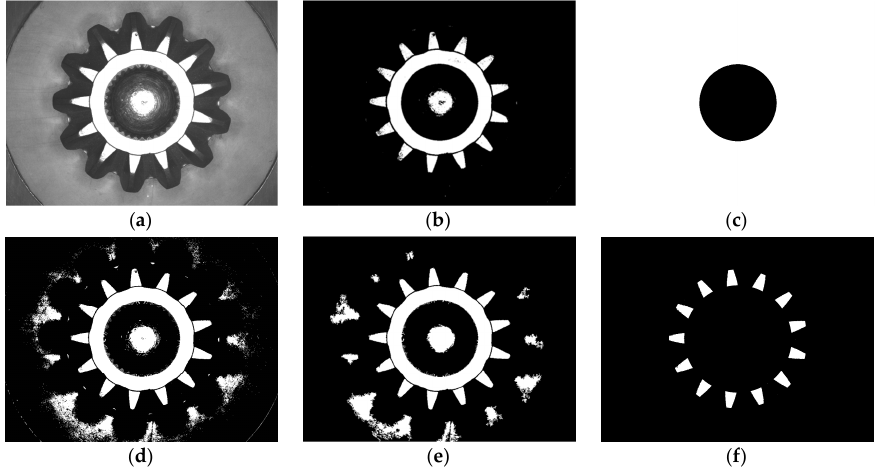
Figure 13. The image preprocess of FRP method: ( a ) Top surface image; ( b ) Segmentation for inner circle (with a larger threshold); ( c ) Inner circle detected; ( d ) Segmentation for teeth end (with a smaller threshold); ( e ) Result of area filting; ( f ) Teeth end image.